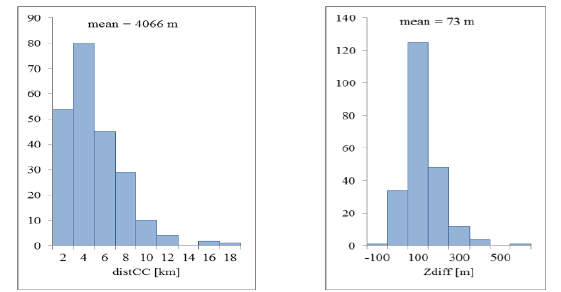
Figure 4. Locational features of the sample tiles The sampled tiles show also sufficient variability of locations within the communes, expressed by distCC and Zdiff distributions. Distance to the commune centres and elevation difference between the tile and the commune centre correspond to varied accessibility of the agricultural land, which was pointed out as one of the triggers of land abandonment (Lieskovský et al., 2015). Finally, we found that CLC land cover data, in spite of their high generalisation, were in most cases sufficient to properly exclude tiles using land cover proportion constraints, as two out of three of these constraints were positively verified using spatially detailed vector